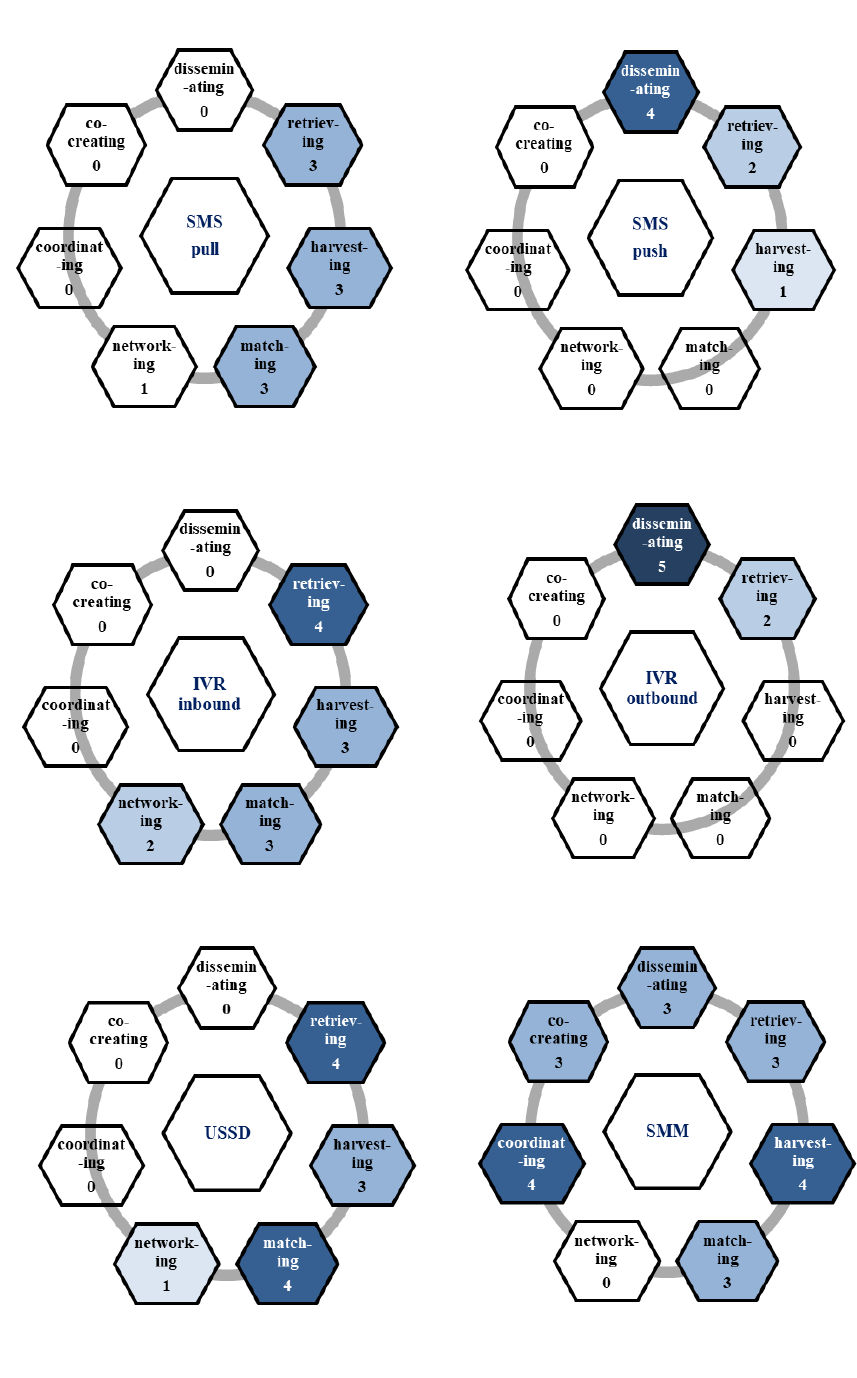
Figure 3: First round of consensus-building: Aggregated results of honeycomb evaluation (nine honeycomb